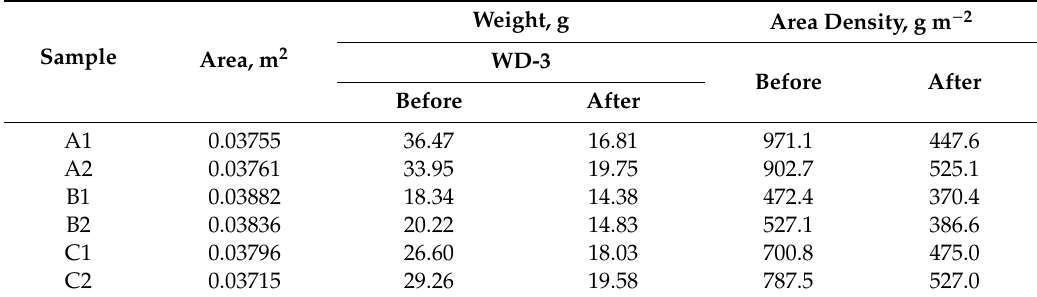
Table 3. Physical parameters of the nonwoven geotextile WD-3 samples (before and after shaking).